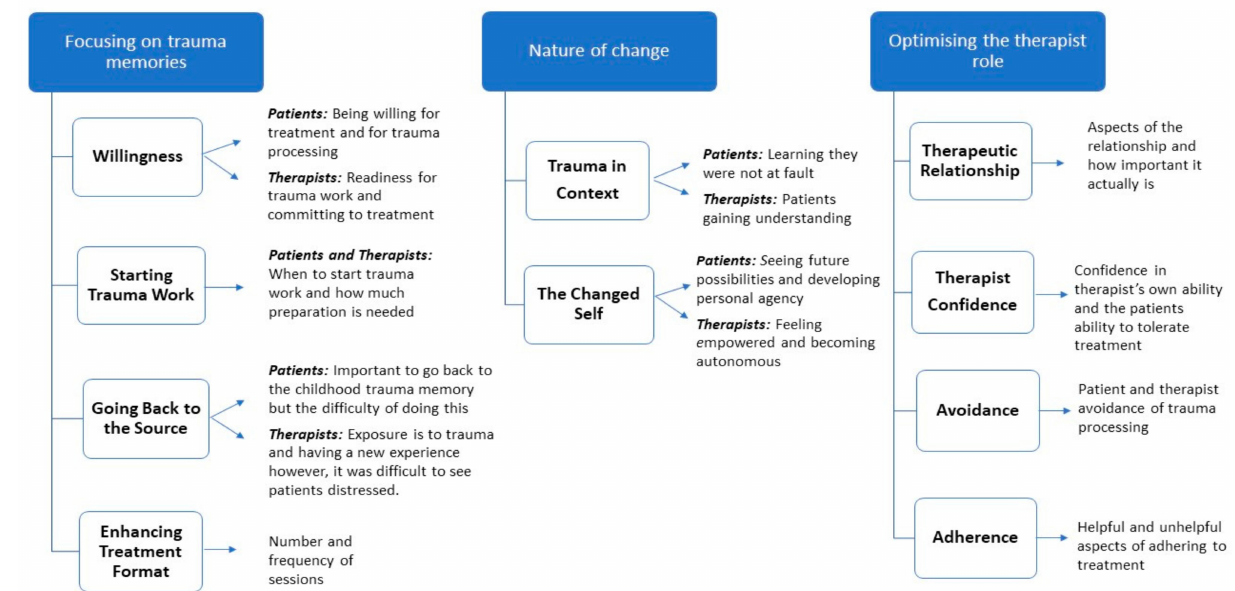
Figure 1. Patient and therapist shared super-ordinate and subordinate themes on the treatment